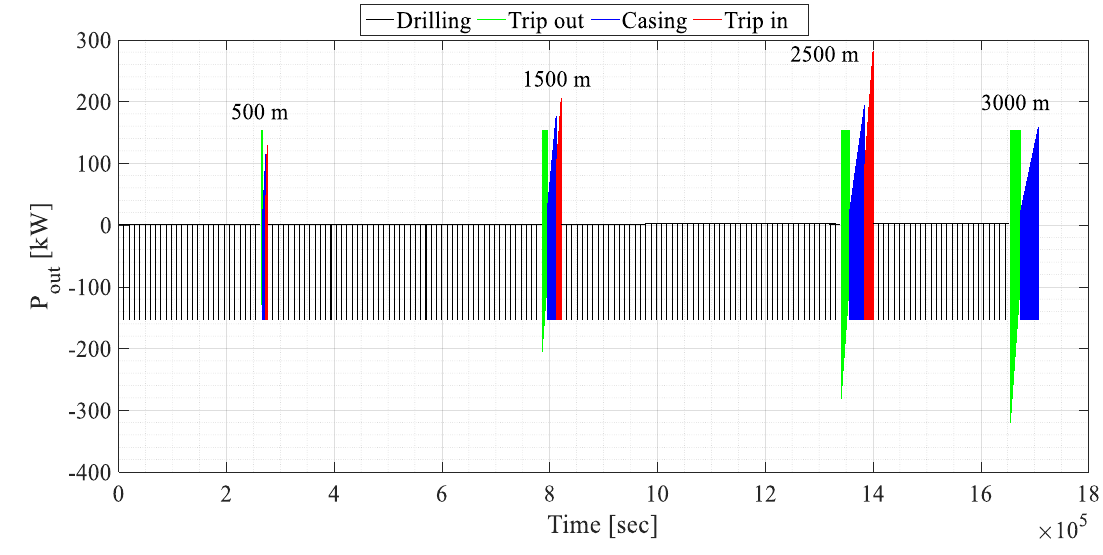
Figure 4. PSU output shaft power.